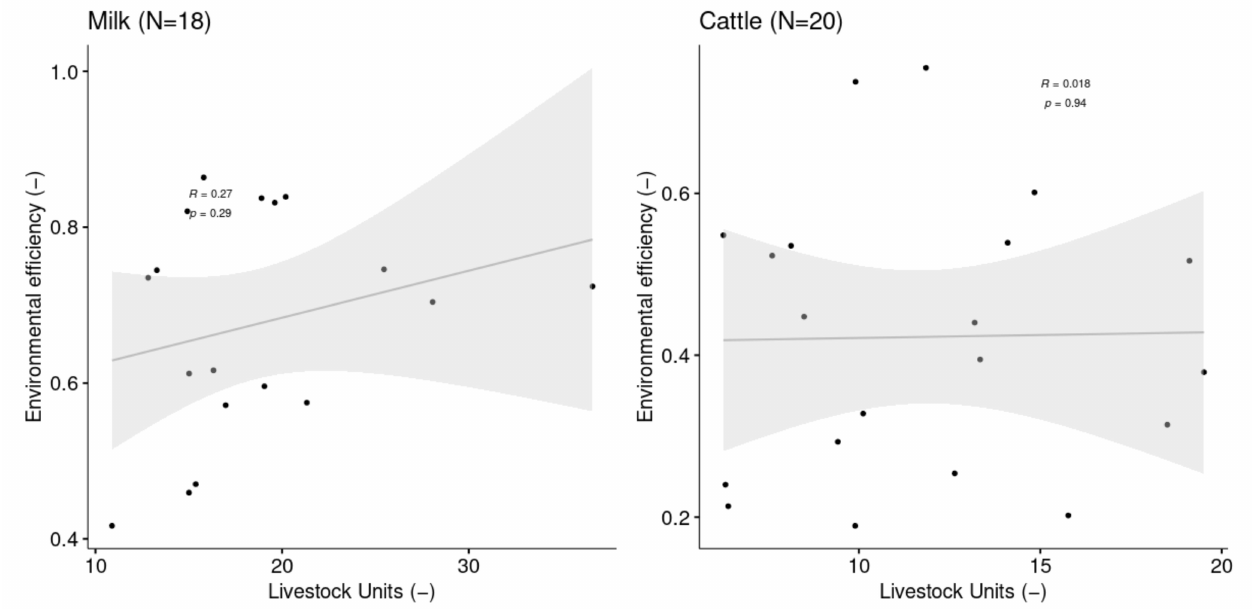
Figure A12. Environmental efficiency for farms with only one (dominant) product group. Farms with all other product groups smaller than 33% of the average product group size (see Appendix A) were considered as ‘non-mixed’ or ‘specialized’ farms. The x -axis shows the size of the product group in Livestock units for animal product groups and hectares for crops. The grey area around the regression line marks the 95% confidence interval. Additionally, the regression coefficient (R) and its p -value ( p ) are